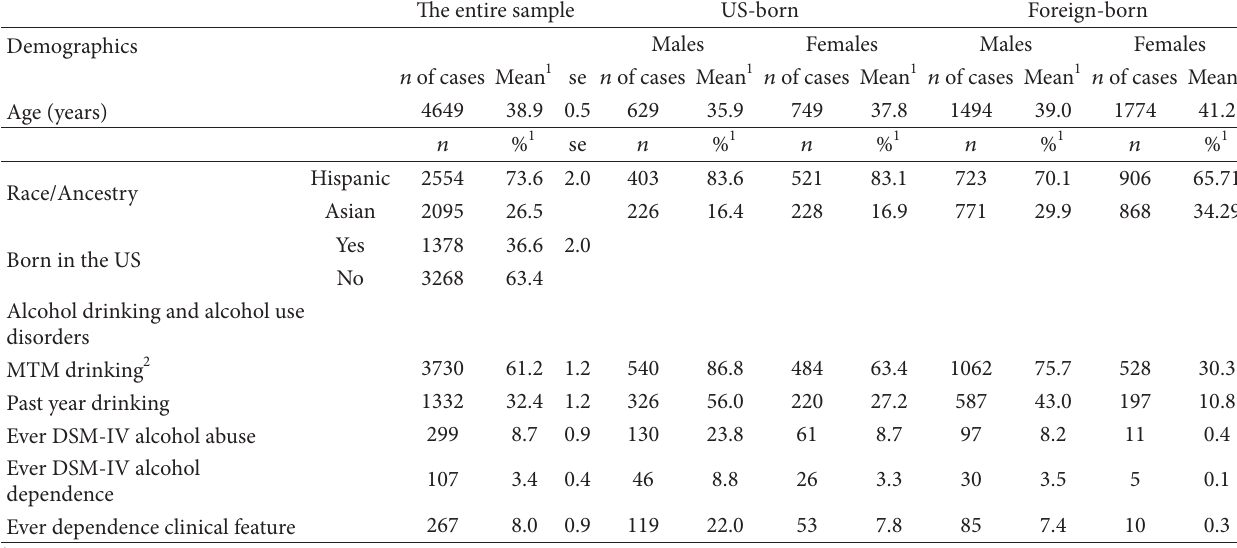
T 1: Description of sociodemographic characteristics and drinking-related outcomes in males and females. Data from NLAAS, 2002- 2003.